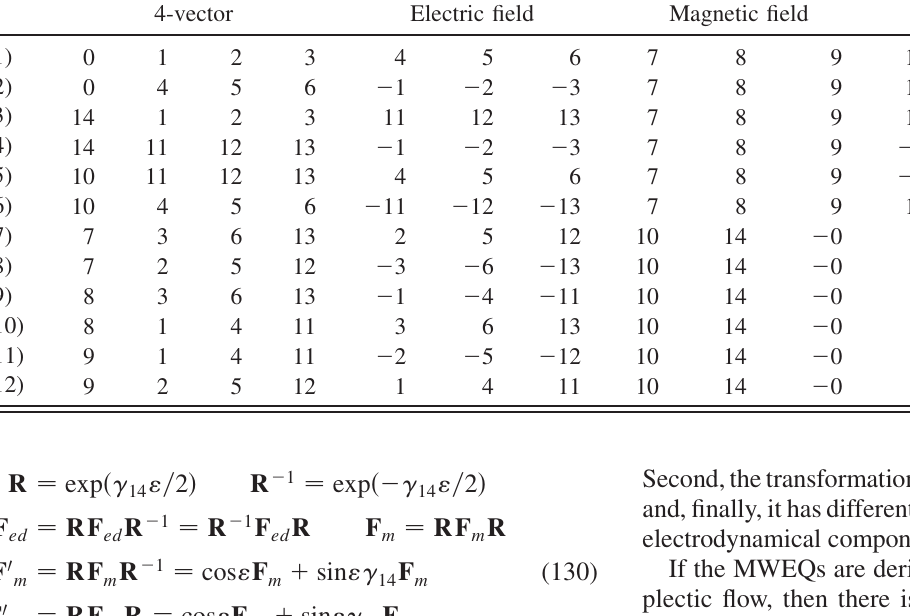
TABLE III. List of the indices of equivalent canonical basis sets of (cid:1) matrices and the corresponding reinterpretations of the matrices relative to the choice of the basis. Negative indices indicate the negative matrix with the index taken as absolute value. ð V are the elements corresponding to the so-called ‘‘axial vector,’’ ‘‘PS’’ is the pseudoscalar. Basis ð (cid:6) ; ~A Þ